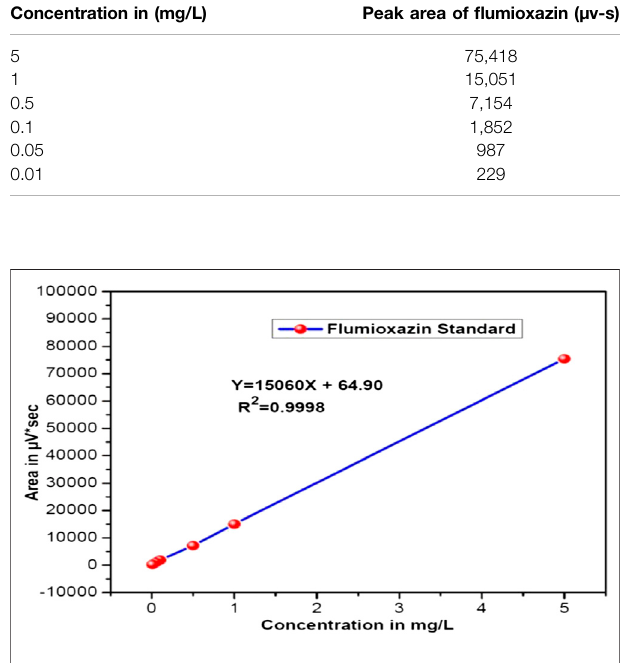
FIGURE 12 | Representative calibration curve of fl umioxazin standard.